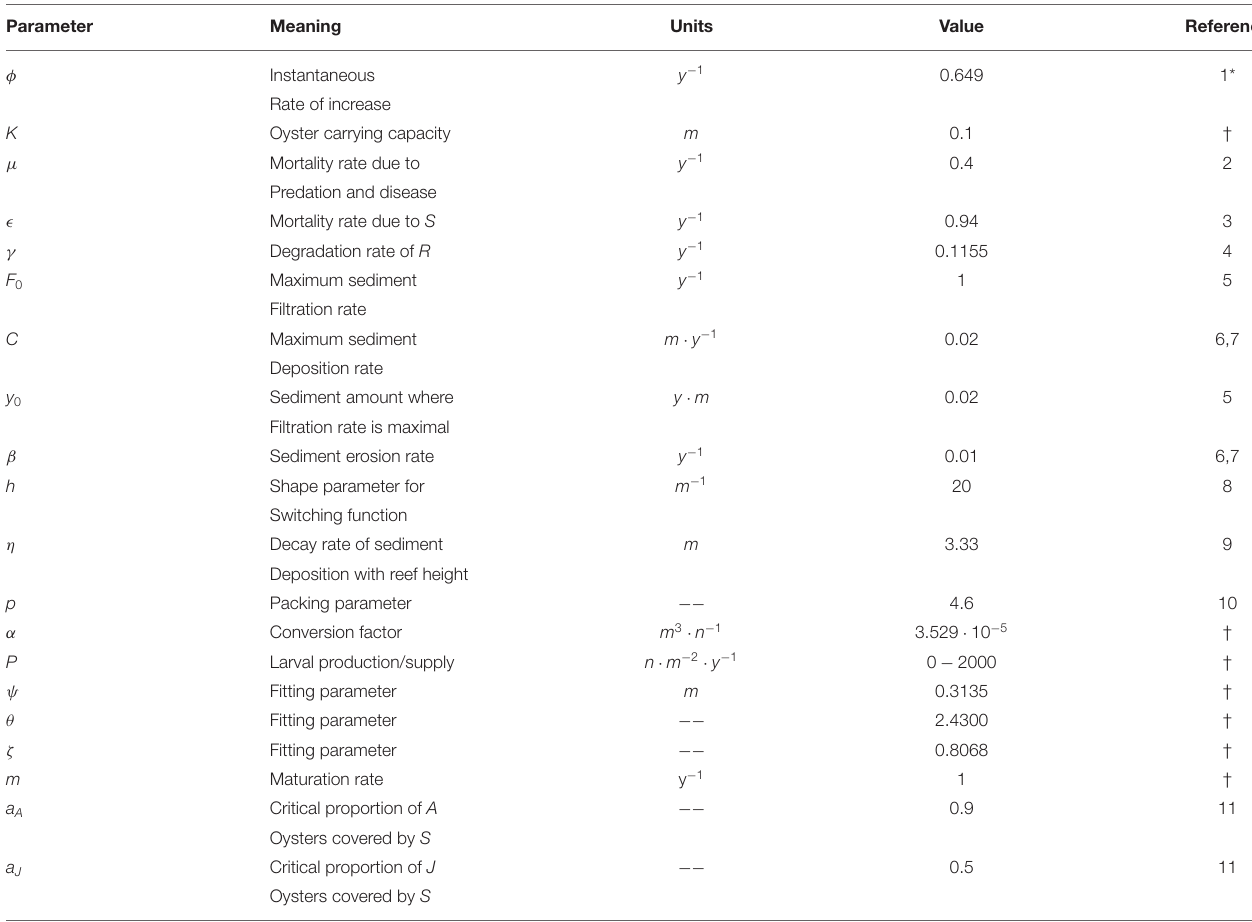
TABLE 2 | Parameter values in the equations.